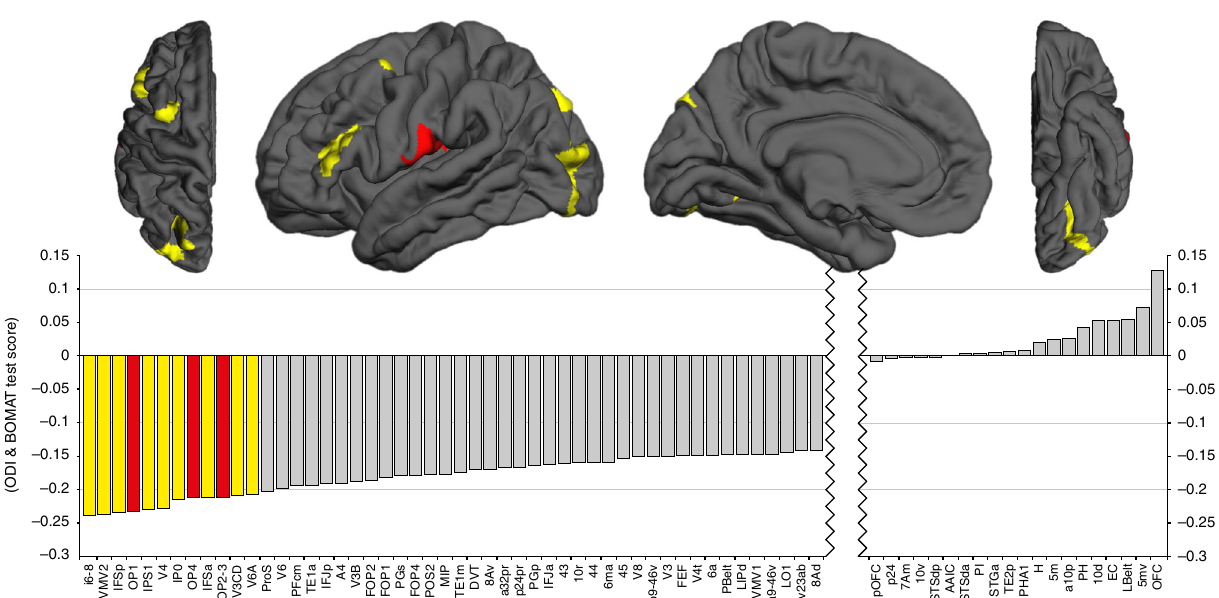
Fig. 3 Partial correlation analyses with data from sample S259 quantifying structure – function associations at the level of single brain regions. For each hemisphere, 180 cortical brain regions were de fi ned based on the multi-modal parcellation scheme provided by the Human Connectome Project. NODDI coef fi cients and volume measures from homotopic brain regions were averaged across both hemispheres, resulting in 180 mean values. Structure – function associations between INVF Cortex and intelligence ( a ) as well as ODI Cortex and intelligence ( b ) were analyzed by means of partial correlations with age, sex, and the remaining cortical brain properties as controlling variables. FDR correction using the Benjamini – Hochberg method was applied to account for a total of 180 comparisons. Partial correlation coef fi cients are depicted as gray bars arranged by magnitude from negative to positive. Due to space restrictions, a middle portion of 110 brain regions exhibiting no signi fi cant structure – function associations is spared out. Statistically signi fi cant partial correlation coef fi cients that survived a critical FDR threshold of q = 0.05 (see Methods) are highlighted in either red or yellow. The yellow color marks signi fi cant partial correlation coef fi cients that are exhibited by brain regions from the P-FIT model of intelligence. Following this color scheme, respective brain regions are marked in either red or yellow on a cortical surface. INVF Cortex = intra-neurite volume fraction representing neurite density in the cortex, ODI Cortex = orientation dispersion index of neurites in the by an increased loss of connections within 10% of non-stimulated during maturation overlap with those of learning in the mature hippocampal spines 45 . Thus, both the ability to produce and brain 42 . Consequently, diverse learning tasks are associated with simultaneous growth and retraction of dendritic and synaptic prune neural connections constitutes the neurobiological foun- processes in involved neural zones 43,44 . Microstructural studies dation of learning and cognition. Perturbations of synaptic and dendritic growth and pruning with confocal imaging on organotypic brain cultures reveal that have grave consequences with regard to cognitive performance 46 . long-term potentiation initially induces synaptic growth, followed